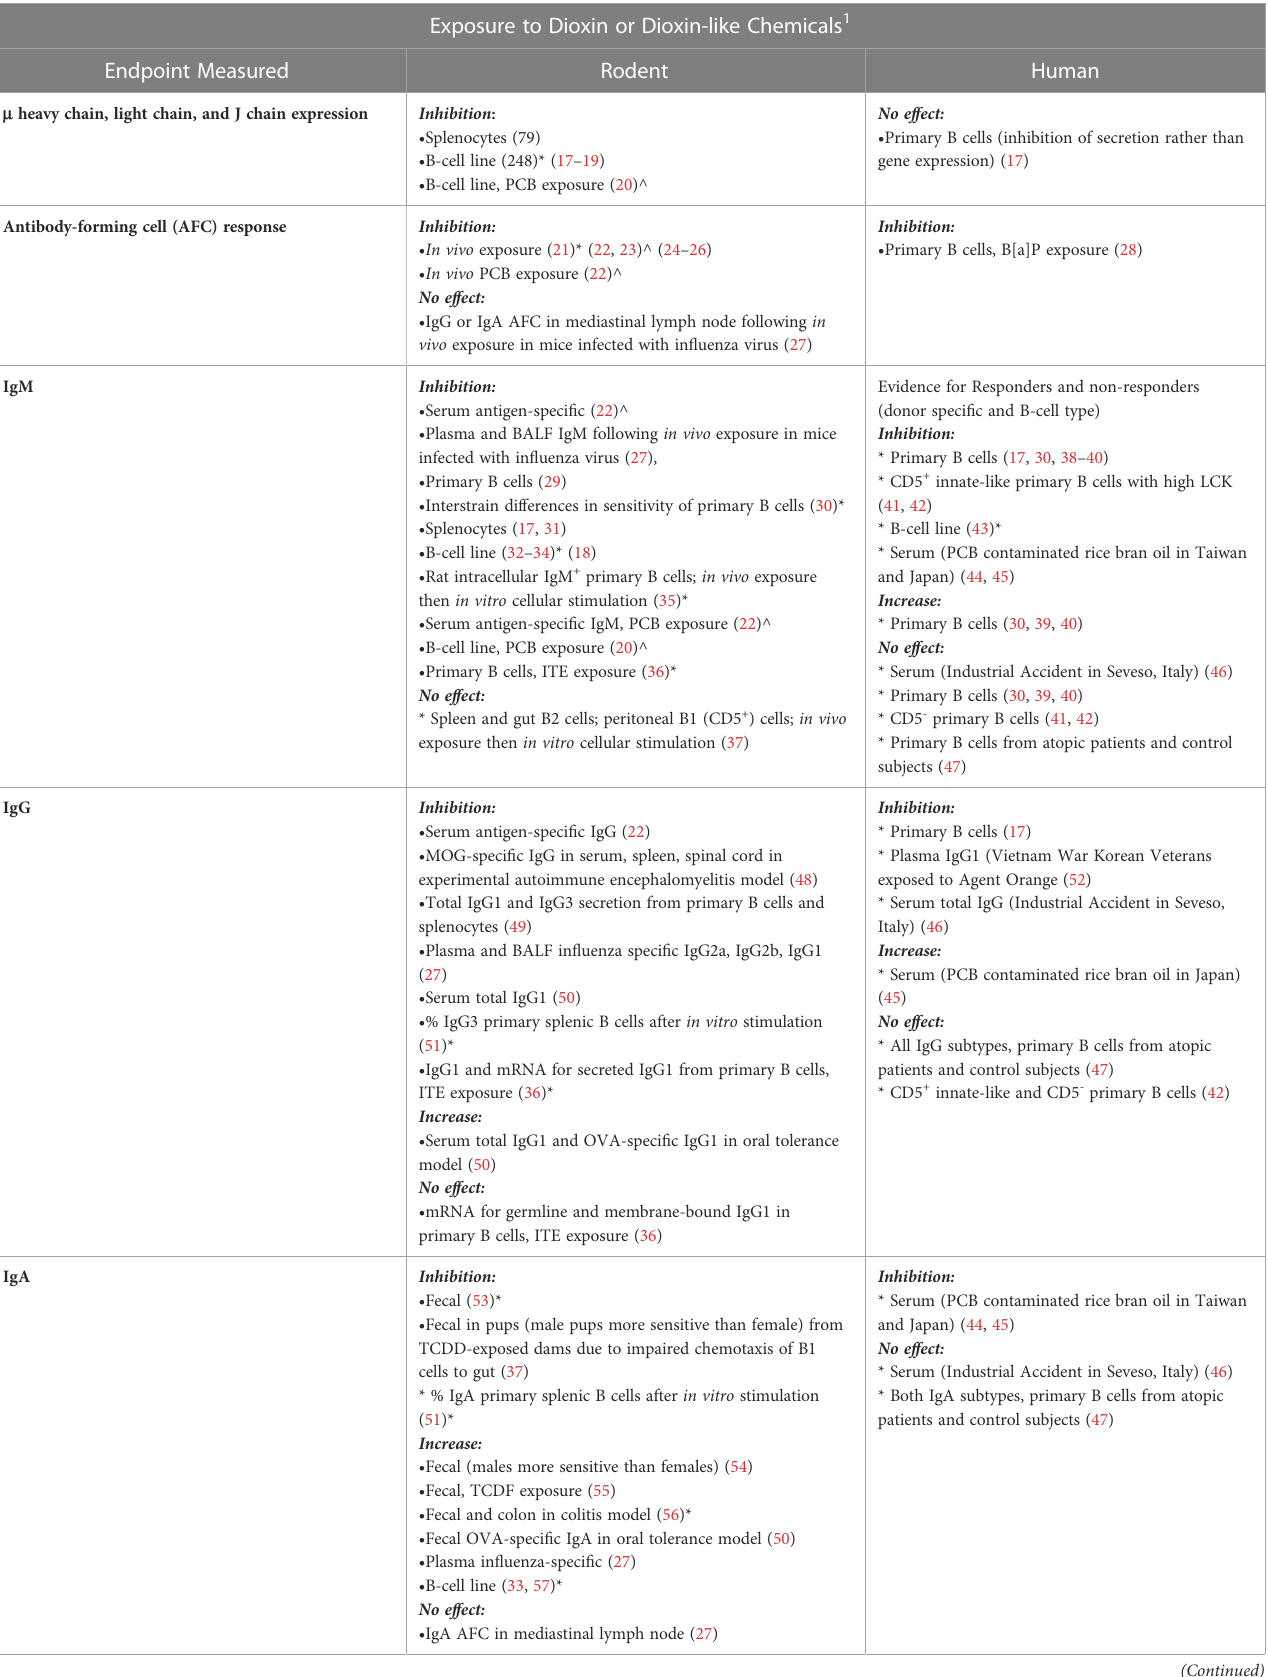
TABLE 1 Effects of dioxin or dioxin-like chemicals on antibody production and role of the AhR. Exposure to Dioxin or Dioxin-like Chemicals 1 Endpoint Measured Rodent m heavy chain, light chain, and J chain expression